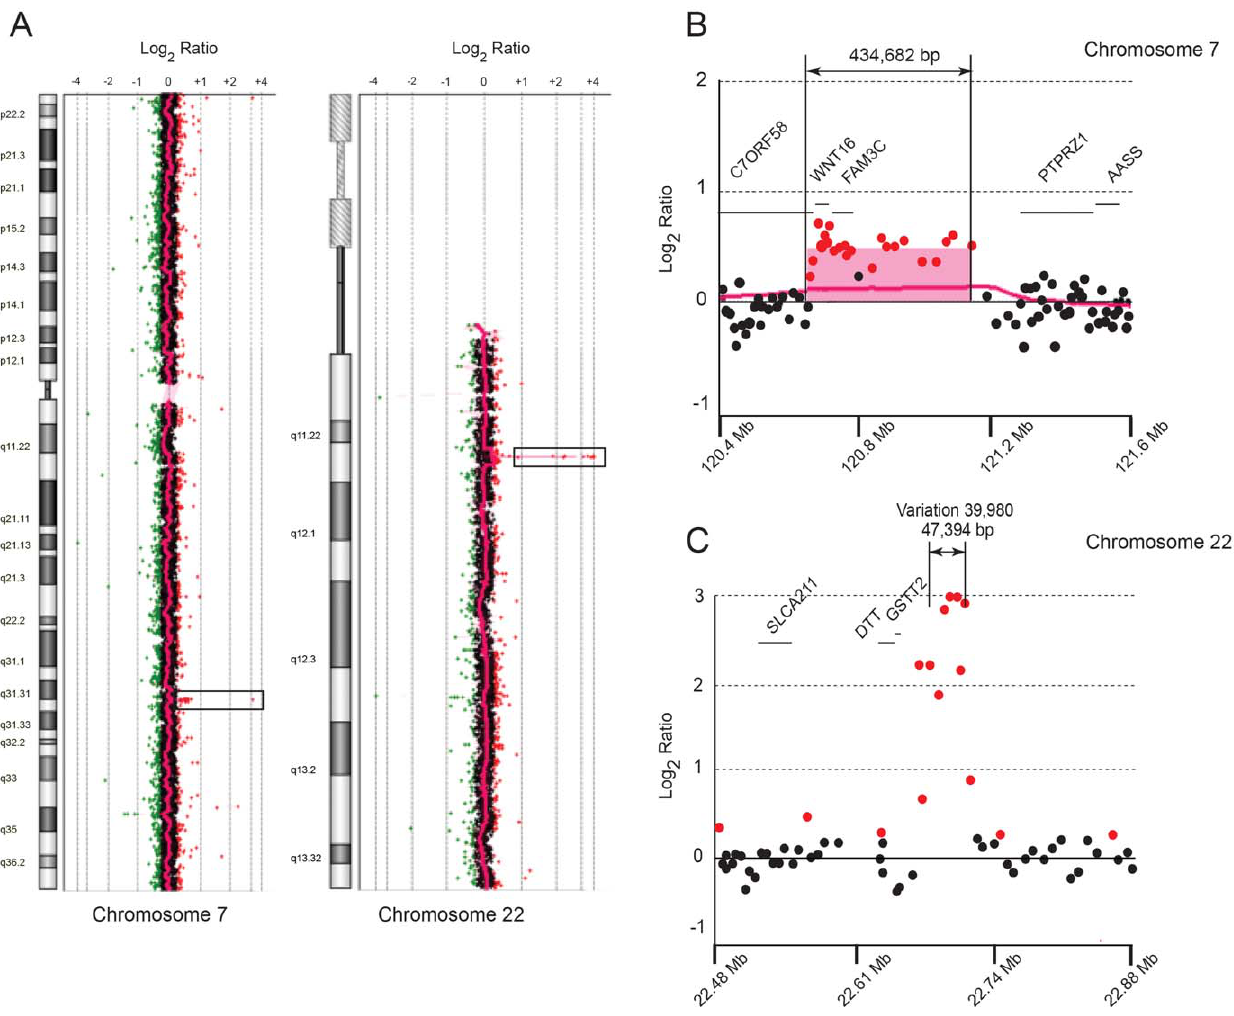
Figure 2. Array CGH array of the index patient showing duplication and amplification of DNA sequences on chromosomes 7 and 22. ( A ) Chromosome 7 and 22 plots displaying gains of DNA sequences, shown in boxes, in the 7q31.3 and 7q22 regions. ( B, C ) Detailed plots of oligonucleotide probes from the microarray along each region of interest denoting the genes and their chromosomal coordinates (hg18) in the duplicated and amplified regions of chromosomes 7 and 22, respectively.